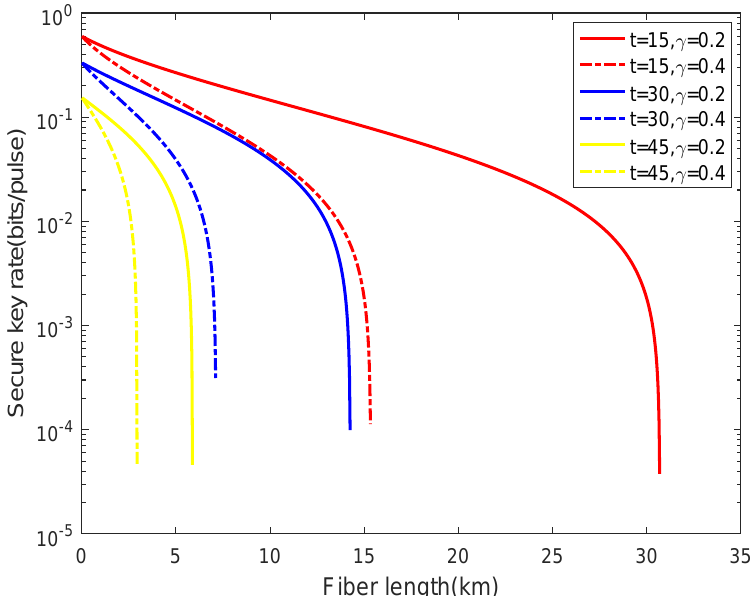
Figure 7. The secret rates of different numbers of legitimate participants and attenuation coefficient for n = 50. The parameters are given by V A = 6, ε = 0.005, κ = 0.98, η = 0.6, and v el =